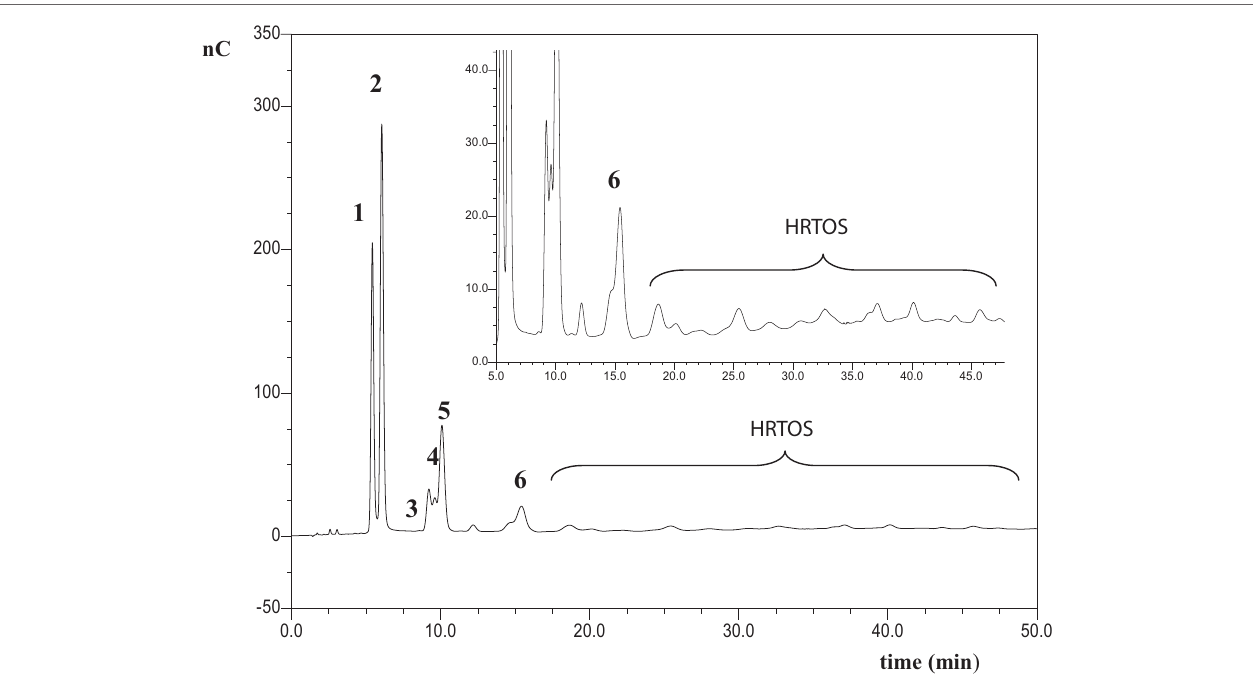
FigUre 1 | hPaec-PaD carbohydrate profile of oligosaccharides formed from hydrolysis of lactulose with the A. oryzae β -galactosidase in soluble form at ph 6.5, 50 °c, 450 g/l of lactulose and 16 U/ml of enzyme after 1 h of reaction . Identified compounds: 1 : galactose; 2 : fructose; 3 : β - d - Gal p -(1 → 6)- d -Gal (6-galactobiose); 4 : β - d -Gal p -(1 → 6)- d -Fru (allolactulose); 5 : lactulose; 6 : β - d -Gal p -(1 → 6)- β - d -Gal p -(1 → 4)- d -Fru (6 ′ -galactosyl-lactulose); HRTOS, high retention time oligosaccharides with DP ≥